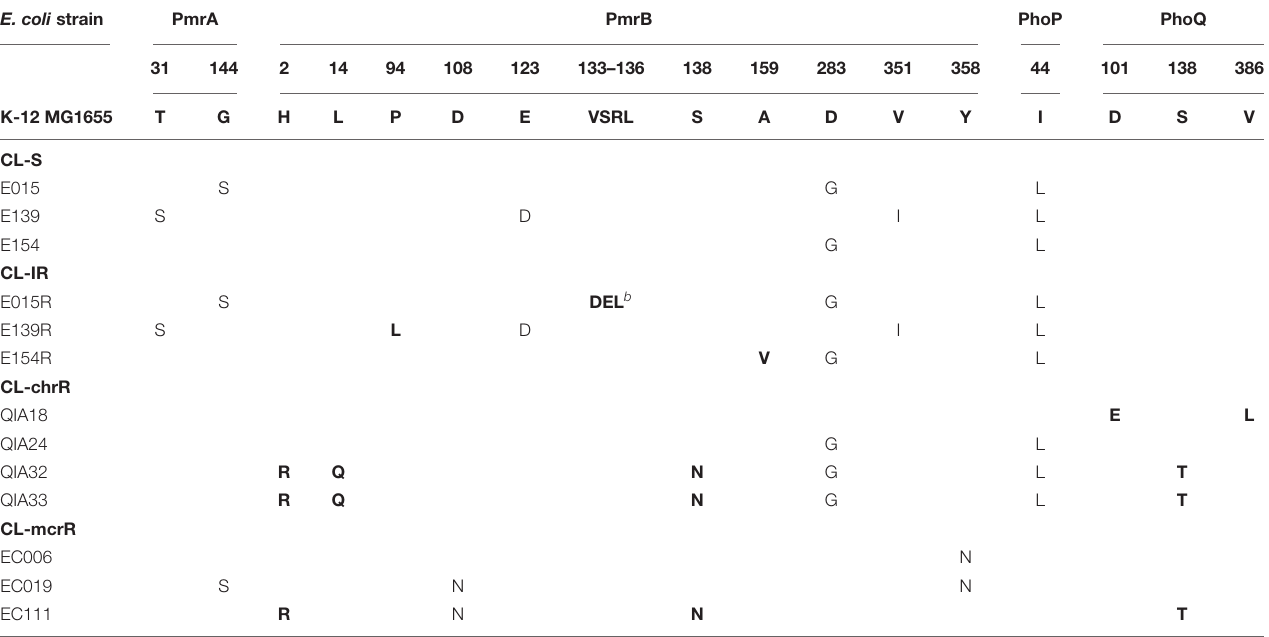
TABLE 2 | Amino acid alterations of PmrAB and PhoPQ. a